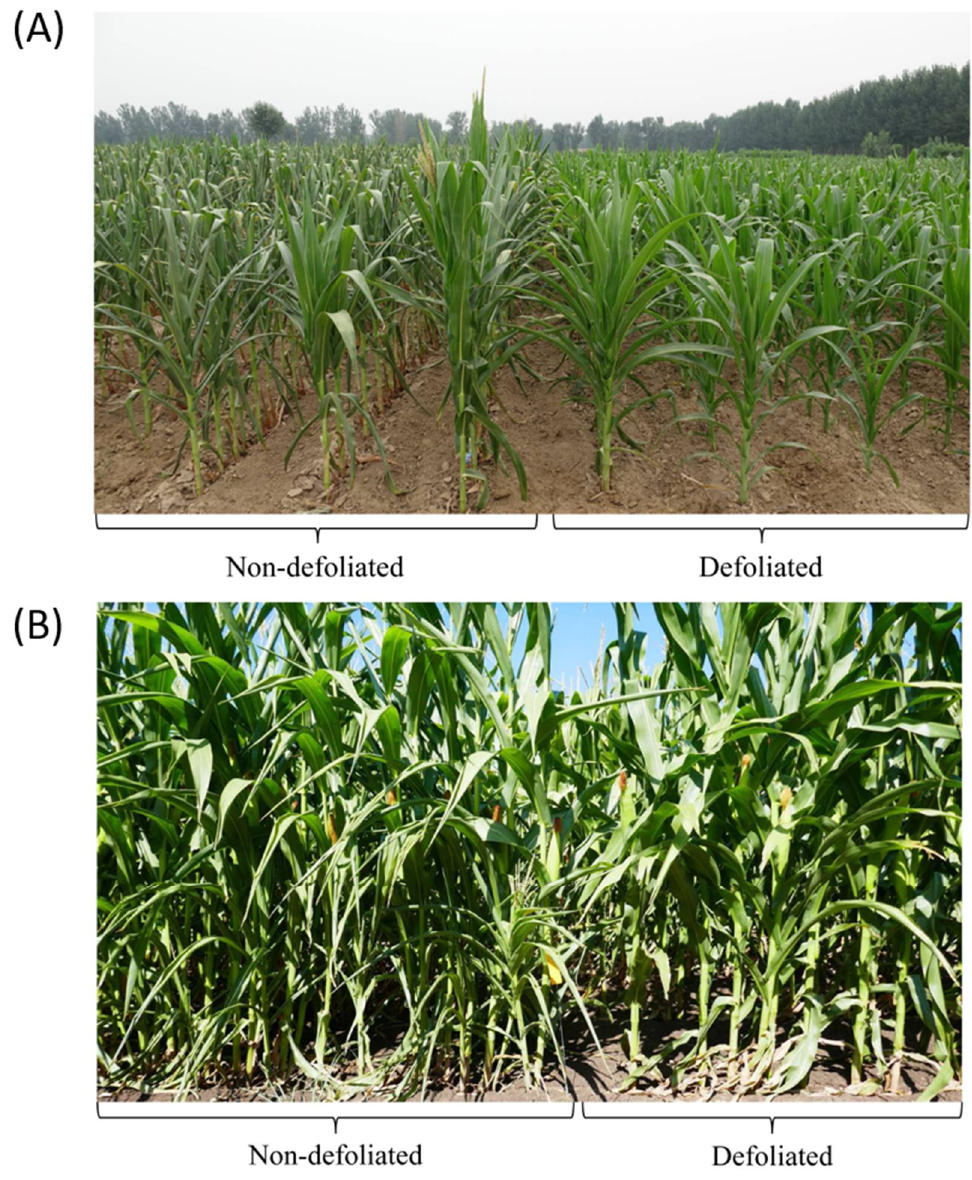
Figure 2. Defoliation improves drought tolerance. Defoliation was carried out by cutting all tissues above the first leaf at D5. The symptom of drought stress (leaf rolling) was clear in the non-defoliated control plants. ( A ) The photo was taken from a trial conducted in northern China. It is of note that, of the non-defoliated control, the row next to the defoliated ones had the best performance. This indicates that the defoliated plants must have used less water. (courtesy of Mr Baojian Su); ( B ) The photo was taken from a trial conducted in Queensland, Australia. The trial was well irrigated (about 40 mm per week) until tasselling. The symptom of water stress appeared in the non-defoliated plants soon after the stopping of irrigation, indicating that defoliation may also improve the capacity of roots in extracting water from the environment. Also note that, different from the non-defoliated controls, few of the defoliated plants grew vegetative tillers (or suckers) which produce very small or no